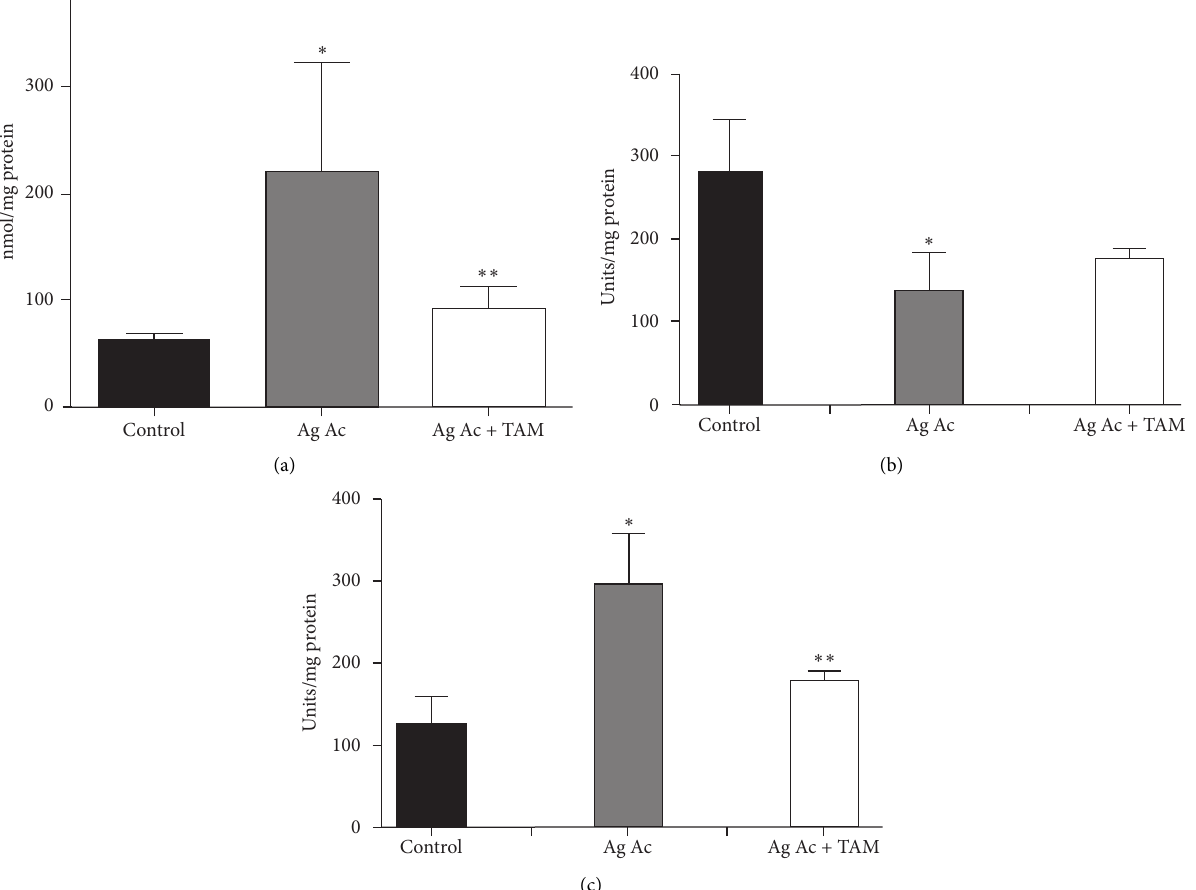
Figure 2: (a). Increased generation of hydrogen peroxide by agaric acid and its inhibition by tamoxifen. Mitochondrial protein (2mg) was incubated in 3ml of a basic medium. Where indicated, 3 µ M agaric acid (Ag Ac) and 20 µ M tamoxifen were added. Results are the mean ± SD of 3 different experiments. ∗ p < 0 . 05 vs. control; ∗∗ p < 0 . 05 vs. Ag Ac. (b). Protective effect of tamoxifen on the agaric acid- induced inhibition of the superoxide dismutase enzyme. The added concentrations of agaric acid (Ag Ac) and tamoxifen were 3 µ M and 20 µ M, respectively. The data represent the mean ± SD of six different experiments. ∗ p < 0 . 05 vs. control; ∗∗ p < 0 . 05 vs. Ag Ac. (c). Agaric acid-induced oxidation of the membrane lipid milieu and the inhibitory effect of tamoxifen. Mitochondrial protein (2mg) was added to 3ml of a basic medium. Where indicated, 3 µ M agaric acid (Ag Ac) and 20 µ M tamoxifen (TAM) were added. The data represent the average of six different experiments ± SD of six different experiments. ∗ p < 0 . 05 vs. control; ∗∗ p < 0 . 05 vs. Ag Ac. Incubation temperature: 25 °